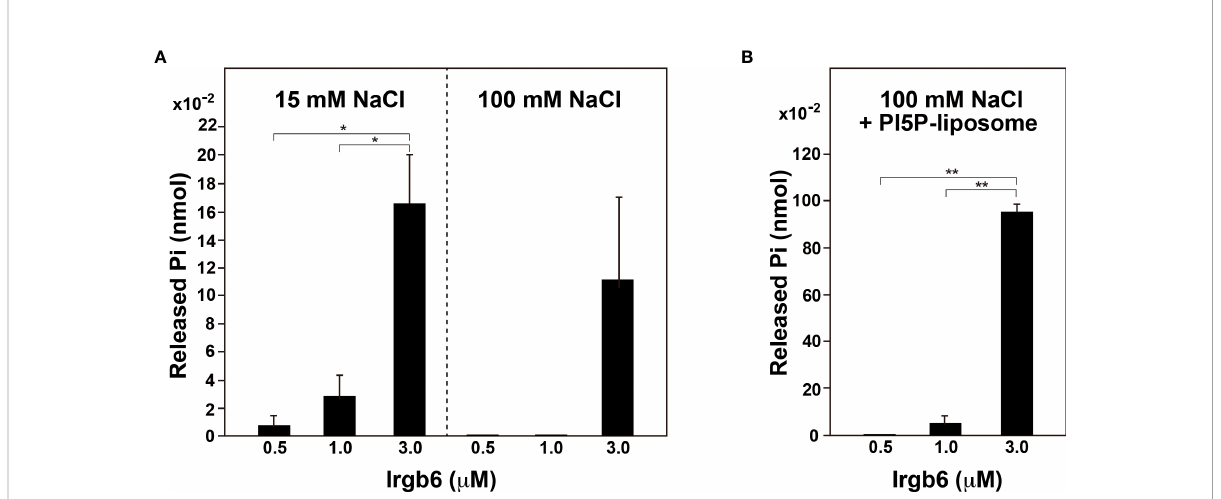
FIGURE 3 PI5P-containing liposomes stimulate Irgb6 GTPase activity. (A) GTPase activity of Irgb6-WT under low (15 mM NaCl) or high (100 mM NaCl) ionic strength conditions. Irgb6-WT at indicated concentrations was incubated in the buffer containing 15 mM or 100 mM NaCl at 37°C for 30 min. Data are means ± S.E.M. of three independent experiments. (*P < 0.05). (B) PI5P-containing liposomes stimulate GTPase activity of Irgb6-WT. Irgb6-WT at indicated concentrations were incubated with 0.1 mg/ml PI5P-containing liposomes in high ionic strength condition (100 mM NaCl) at 37°C for 30 min. Data are means ± S.E.M. of three independent experiments. (**P <